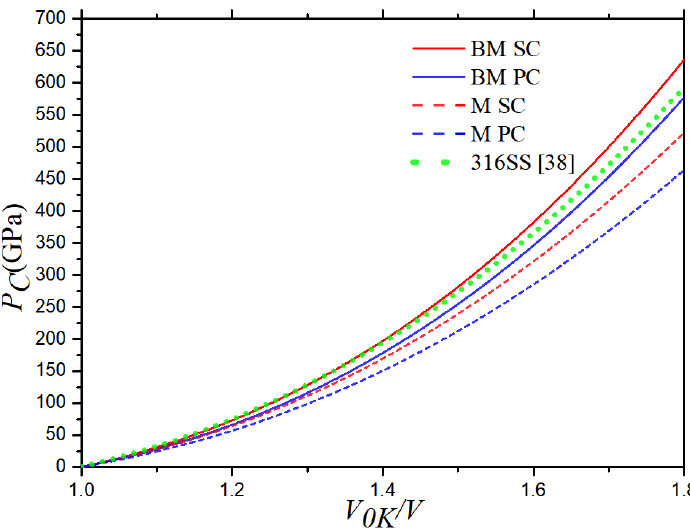
Figure 6. Cold pressure curves of SC and PC 316 stainless steel.